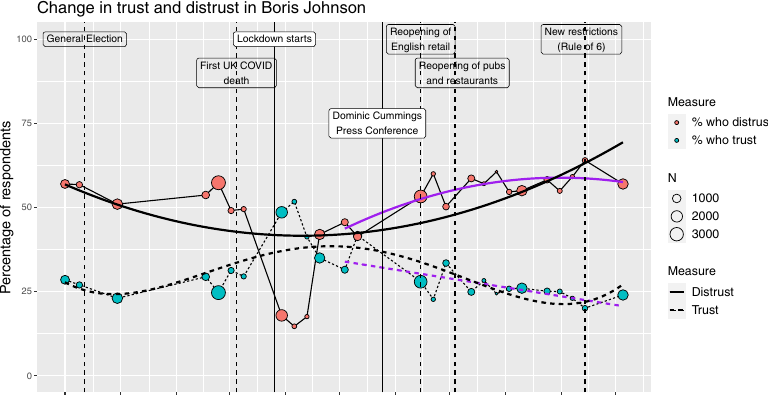
Fig. 2 Change in trust and distrust in Boris Johnson from December 2019 to October 2020. Notes. Trend lines for the full-time period are displayed in black and trend lines for the post-Cummings period of May 2020 onwards are displayed in purple. The key events for the fi rst UK lockdown and the Dominic Cummings scandal are displayed. Other labelled events are to provide additional contextual information but are not necessarily related to changes in trust.